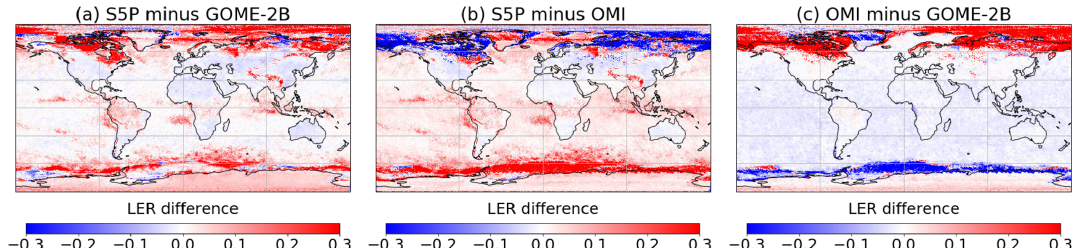
Figure 11. Albedo difference maps between TROPOMI, GOME-2 and OMI for October 2018. North of 60 ◦ N the discrepancy between the three datasets reaches a maximum due to snow/ice conditions. While S5P overestimates compared to GOME-2, it underestimates compared to OMI.